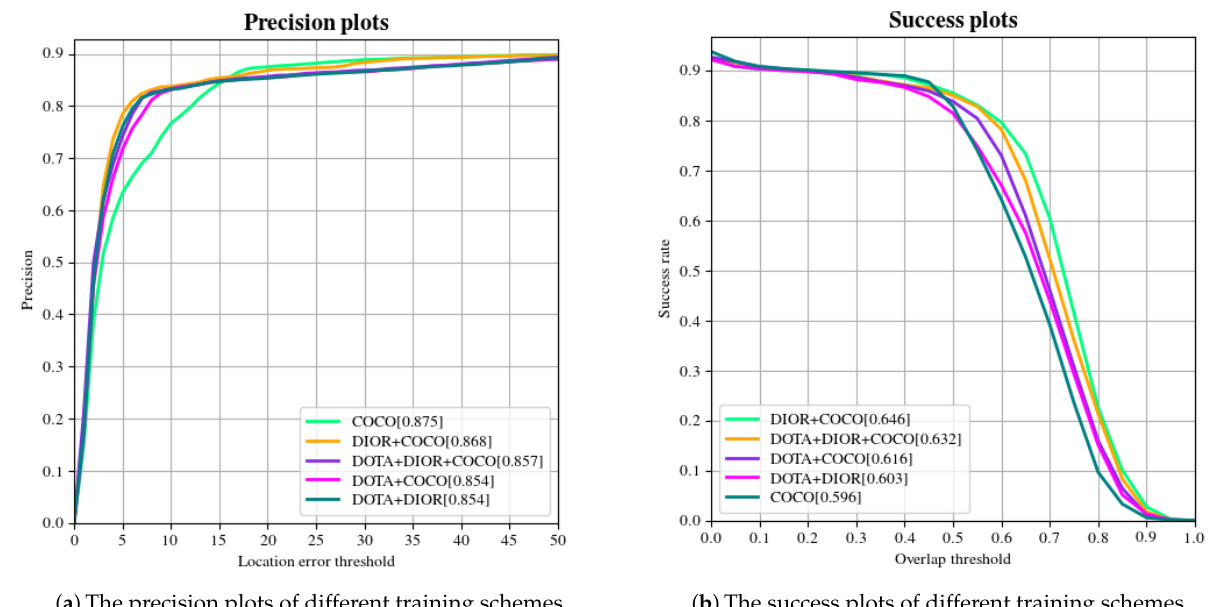
Figure 6. The precision plots and success plots of different training schemes for the proposed